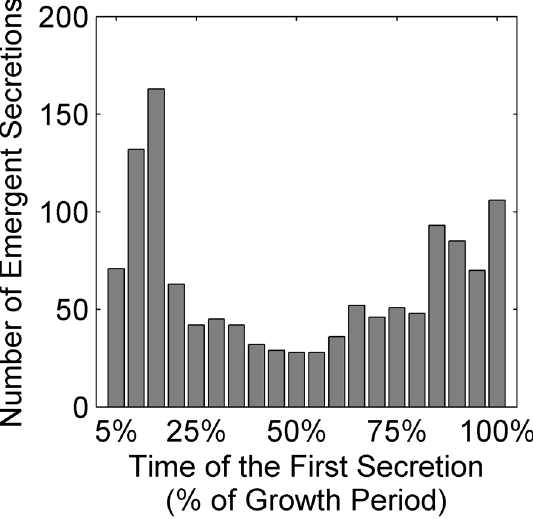
Figure 6. The number of emergent secretion events detected throughout the growth of all community/media combinations included in our analysis. The earliest secretion time point for each event was recorded and presented here as the percentage of the entire growth period in the corresponding community/media settings to account for variability in total growth time among the different simulations.